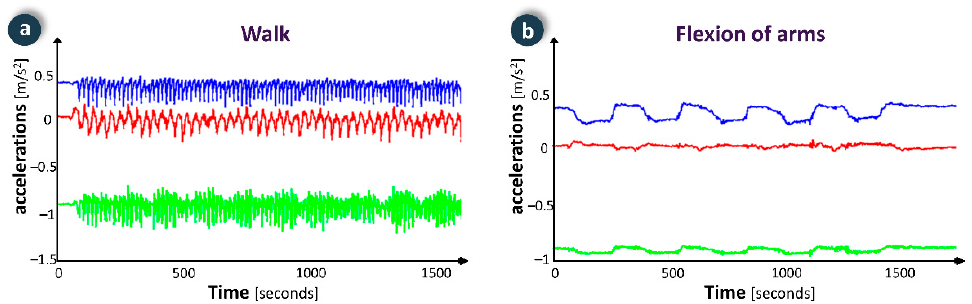
Figure 7. Examples of physical activity monitoring data in two exercises: ( a ) walk; ( b ) flexion of arms.